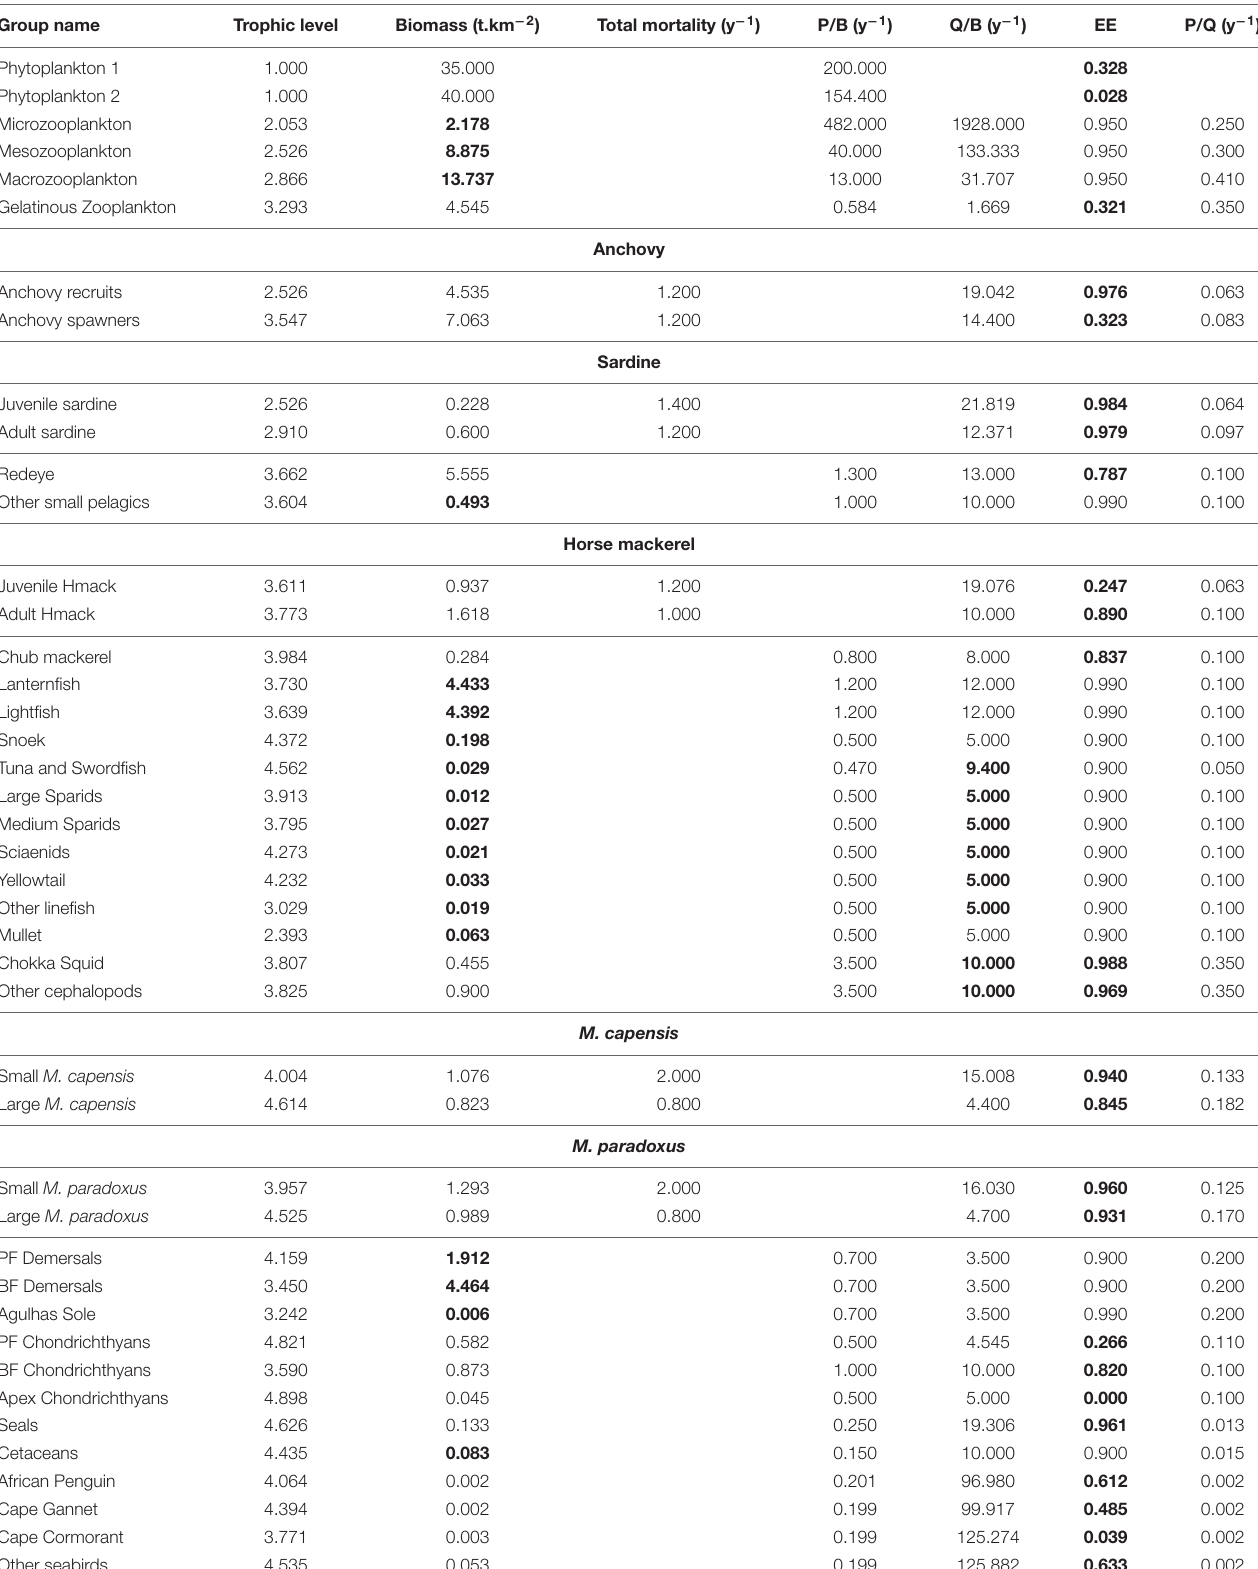
TABLE 2 | Balanced parameters for the revised model of the Southern Benguela in